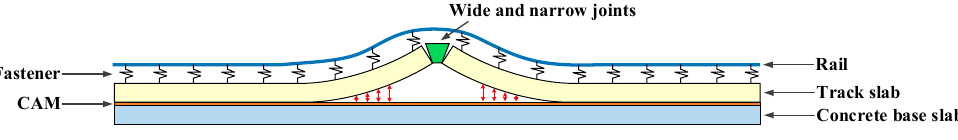
Figure 2. Diagram of slab arching.